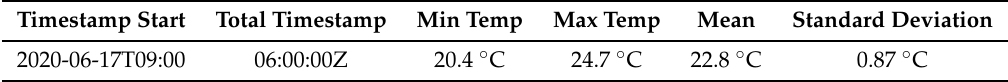
Table 1. Statistical table of measurements of the IoT nodes.